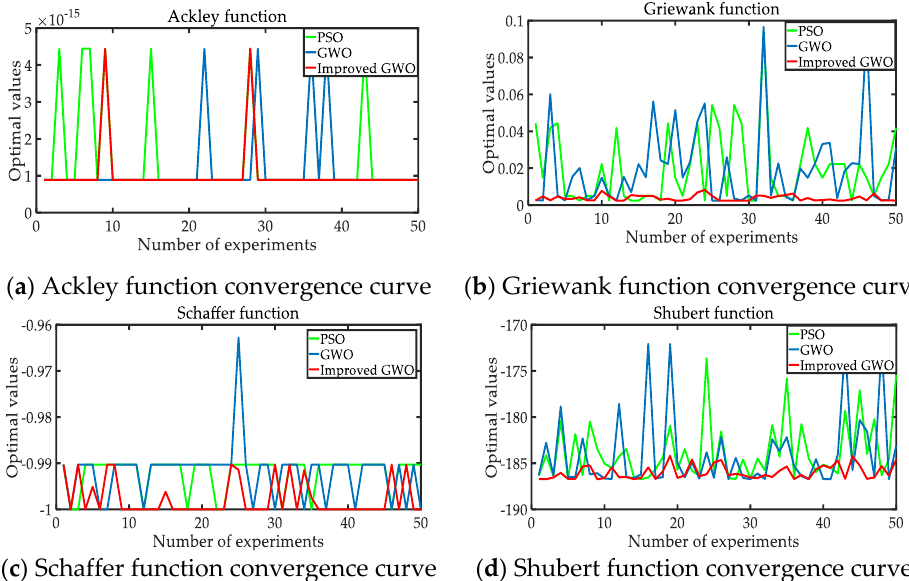
Figure 4. Four classic test function convergence curves.